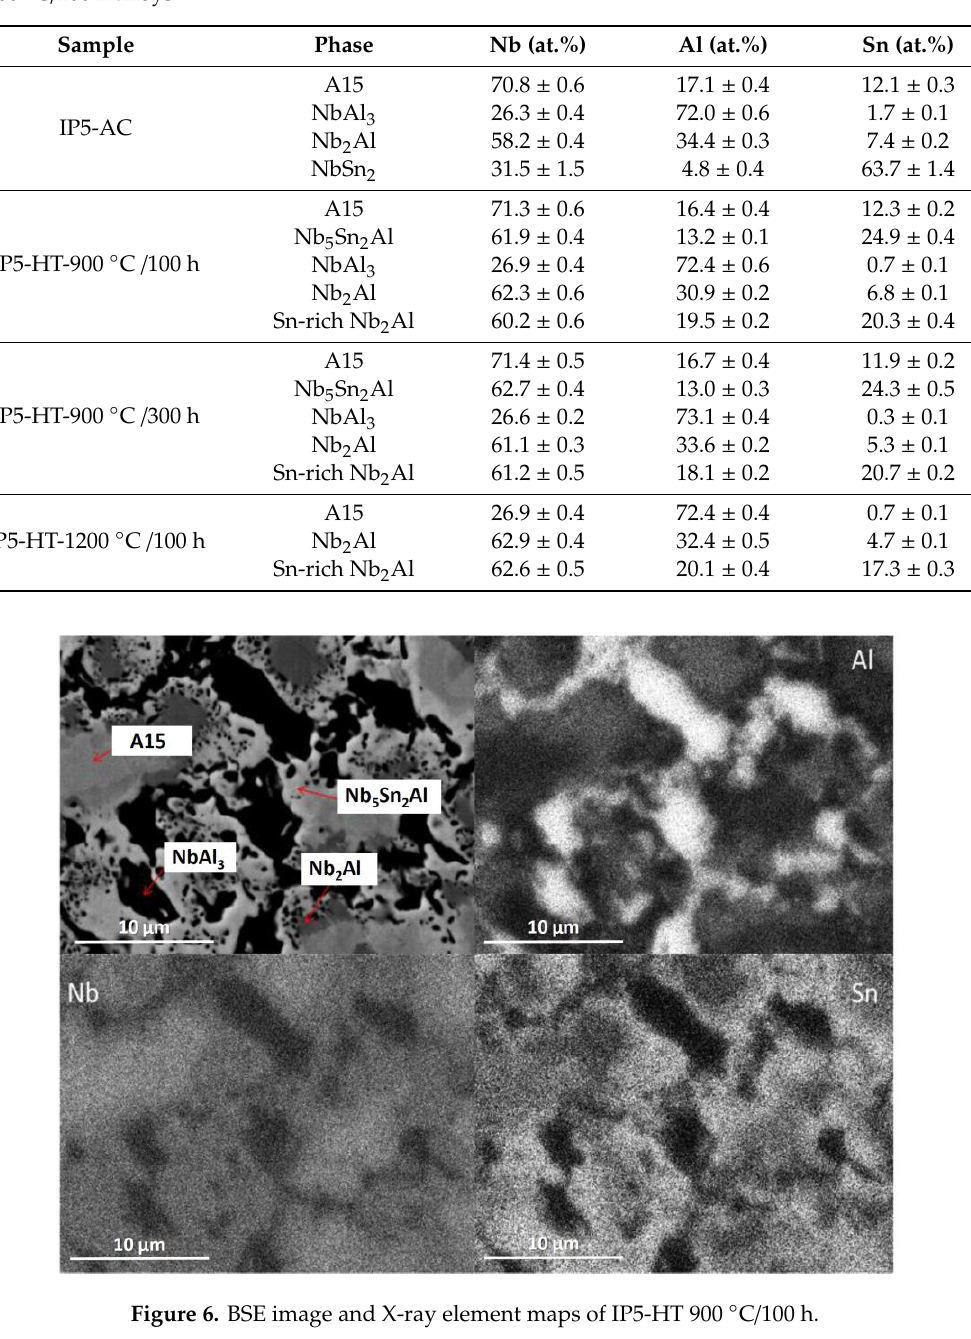
Table 3. EDS analysis of the phases in IP5-AC, IP5-HT 900 ◦ C / 100 h, IP5-HT 900 ◦ C / 300 h and IP5-HT 1200 ◦ C / 100 h alloys.